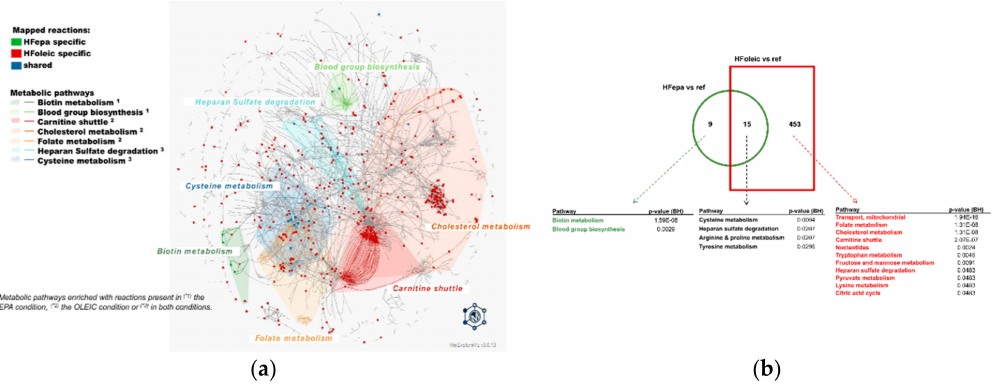
Figure 4. Connections between regulated metabolic pathways in HFoleic and HFepa goups. Genes di ff erentially expressed from HFepa vs. reference and HFoleic vs. reference biological conditions were used to identify related metabolic reactions in MetExplore allowing a complementary exploration of enriched metabolic pathways. Metabolic reactions associated with modulated genes in both HFepa and HFoleic conditions were mapped in the Mus musculus metabolic network. ( a ) The Figure shows a global network of mapped metabolic reactions. Reactions in red are HFoleic-related; reactions in green are HFepa-related; blue reactions are both regulated in HFoleic and HFepa groups. Represented metabolic pathways correspond to metabolic pathways enriched with reactions present in the EPA condition (1) , in the oleic condition (2) or in both conditions (3) . ( b ) Representation of the number of identified reactions and the significantly enriched related metabolic pathways according to the MetExplore analysis in the two comparisons that exhibited significant di ff erential gene expression (HFoleic vs. reference and HFepa vs.